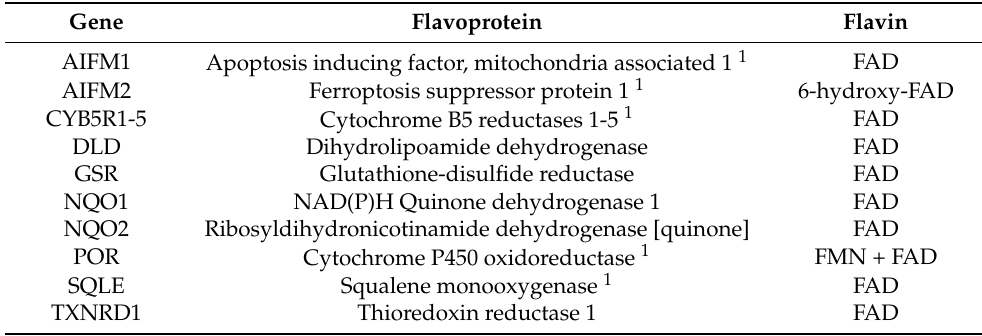
Table 1. Human flavoproteins discussed in this